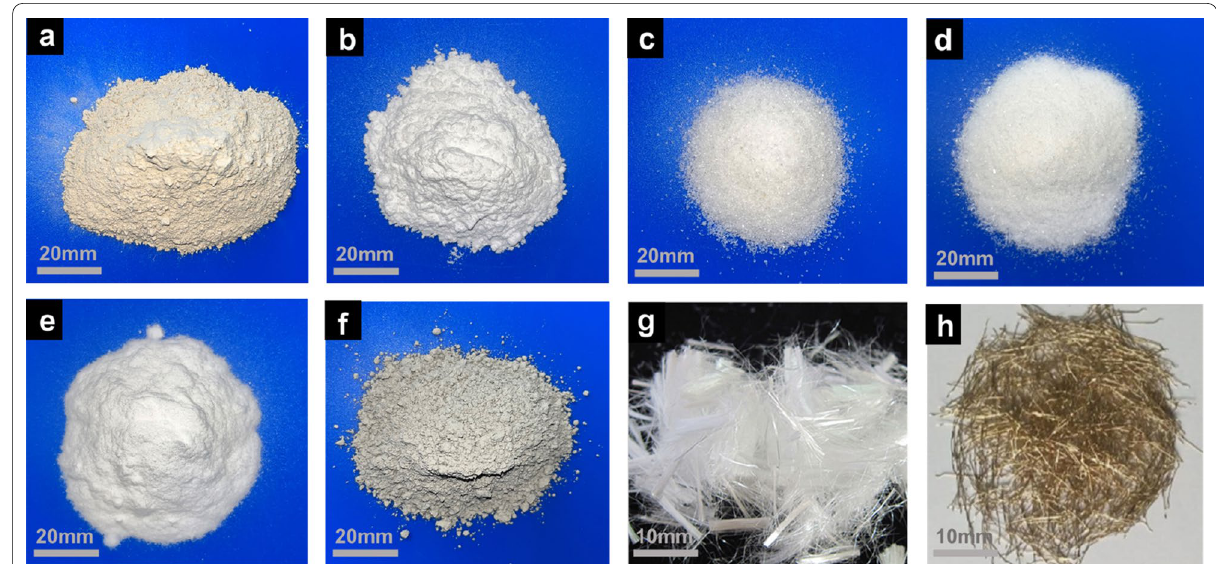
Fig. 1 Illustration of the appearance of a MgO, b quartz sands, c , d two types of industrial-Grade KH 2 PO 4 , e borax, f fly ash, g PP fibres and h MSF,